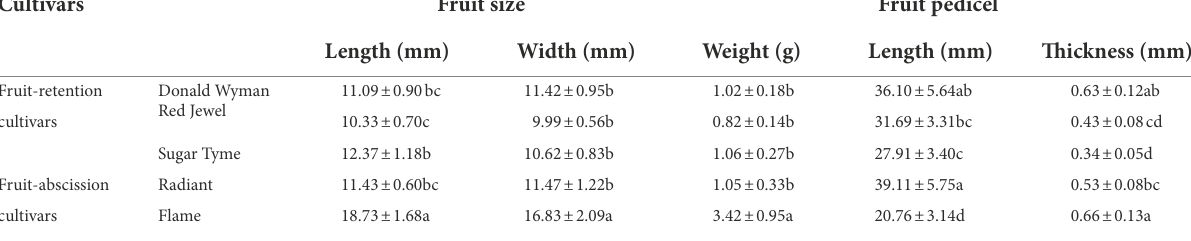
TABLE 1 Fruit-related traits description in fruit-retention and -abscission cultivars of ornamental crabapple. Cultivars